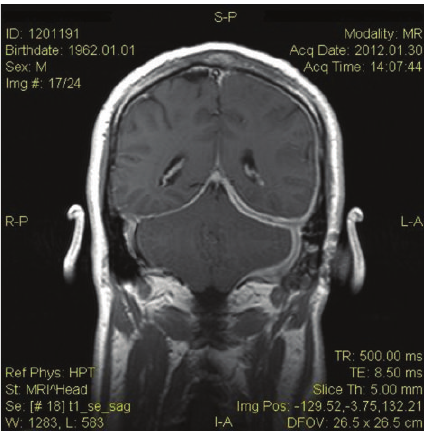
Figure 1: Gadolinium-enhanced coronal T1-weighted MRI scan showing pachymeningeal enhancement over the left temporal cere- bral convexity, the left cerebellar convexity, and the left side of tentorium cerebelli. Also, there is left mastoiditis.